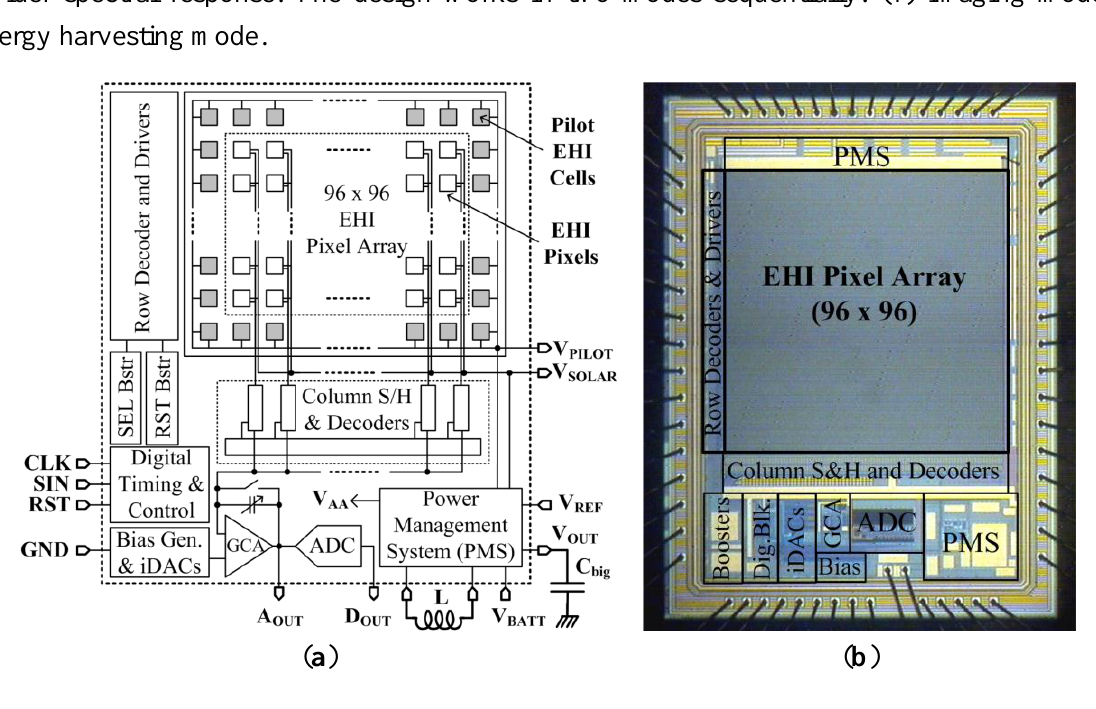
Figure 1. Block diagram and die micrographs of the ultra-low power EHI type